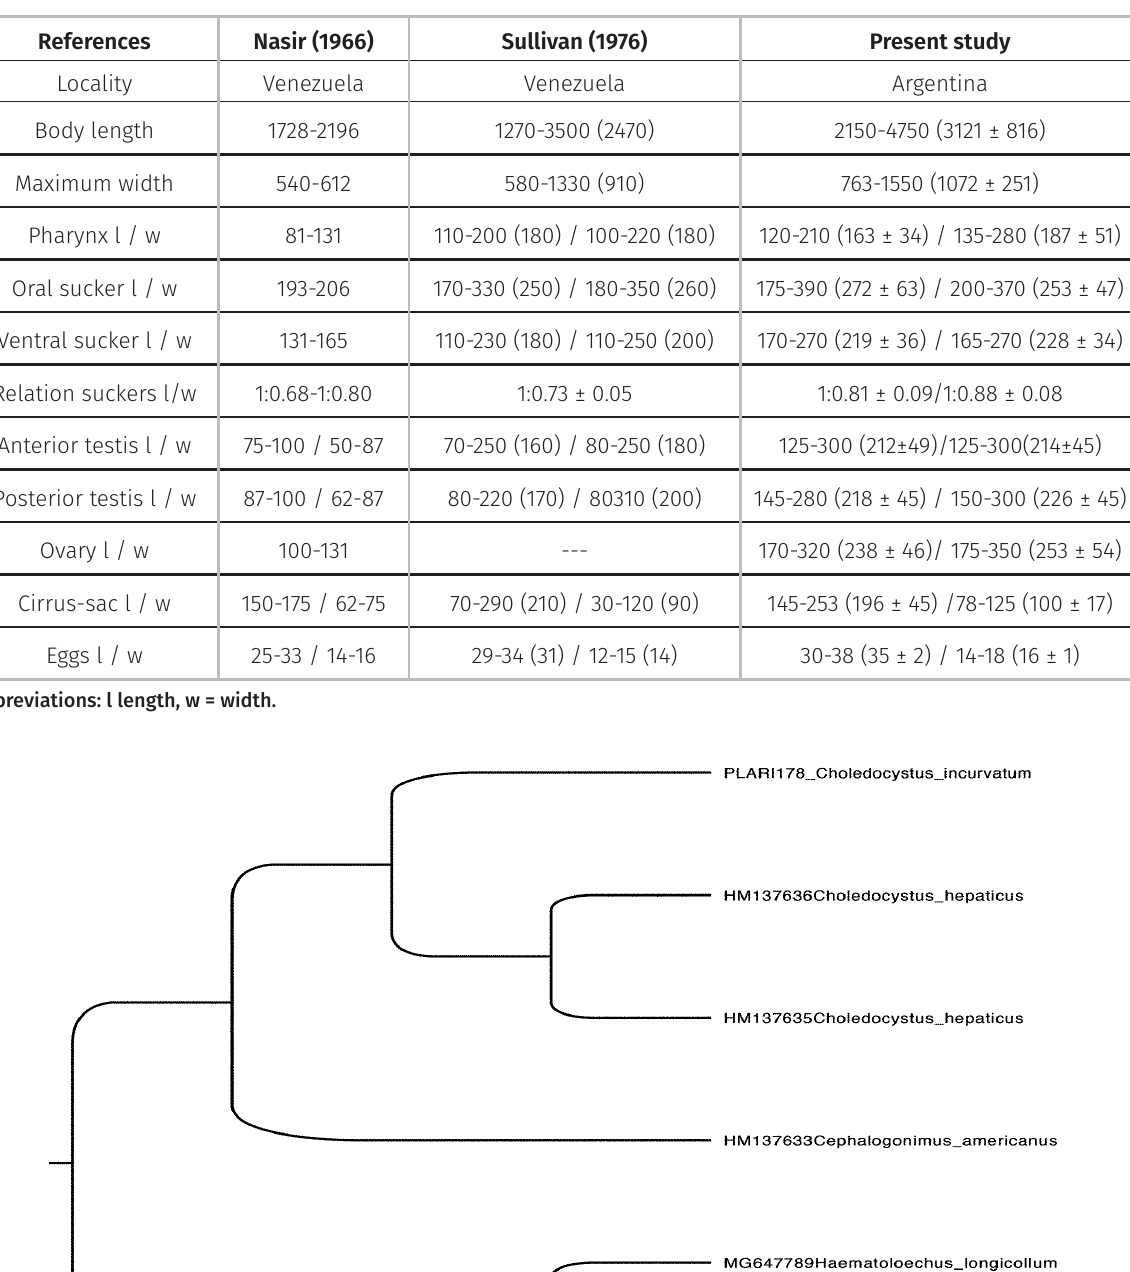
Table I. Comparative morphometrics of Choledocystus incurvatum found in Pseudis paradoxa from the Chacoan region, Argentina.